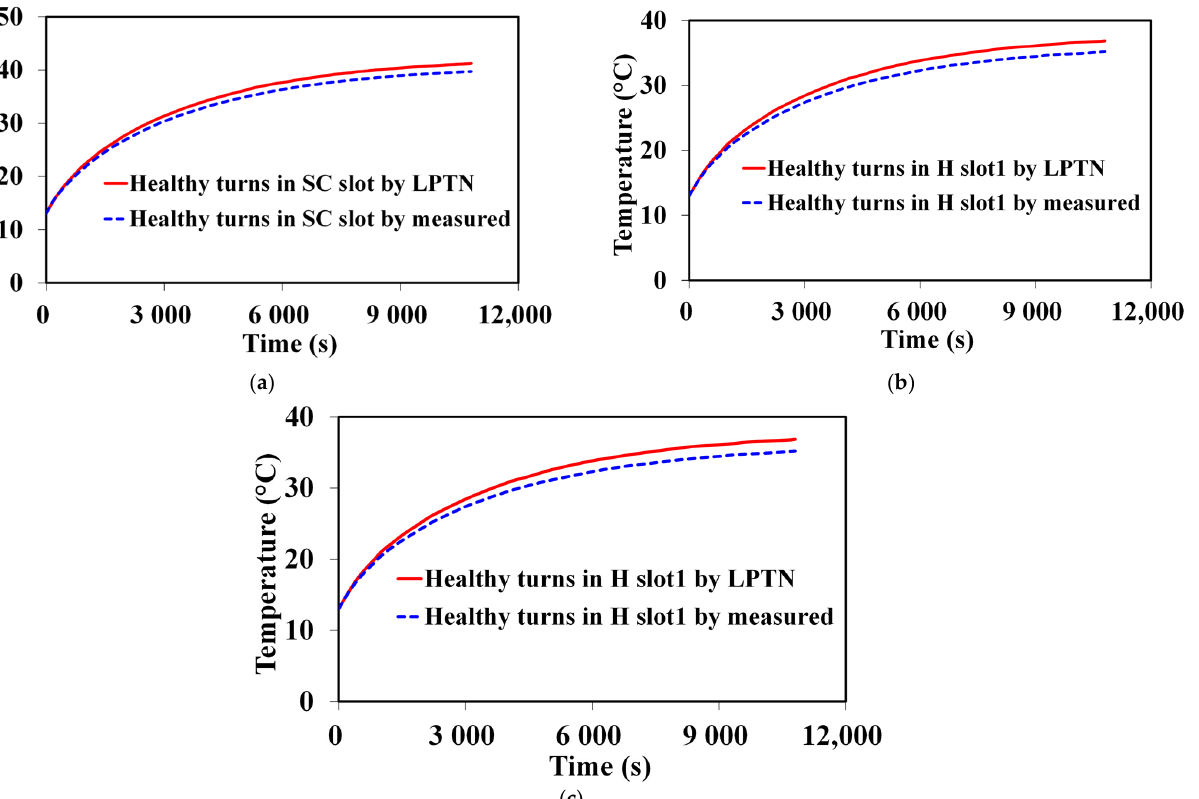
Figure 20. Comparison of LPTN and measured transient temperature for each part. ( a ) Healthy turns in SC slot. ( b ) Healthy turns in H slot1. ( c ) Stator teeth near SC turns. Table 7. Error between LPTN model and experimental results.